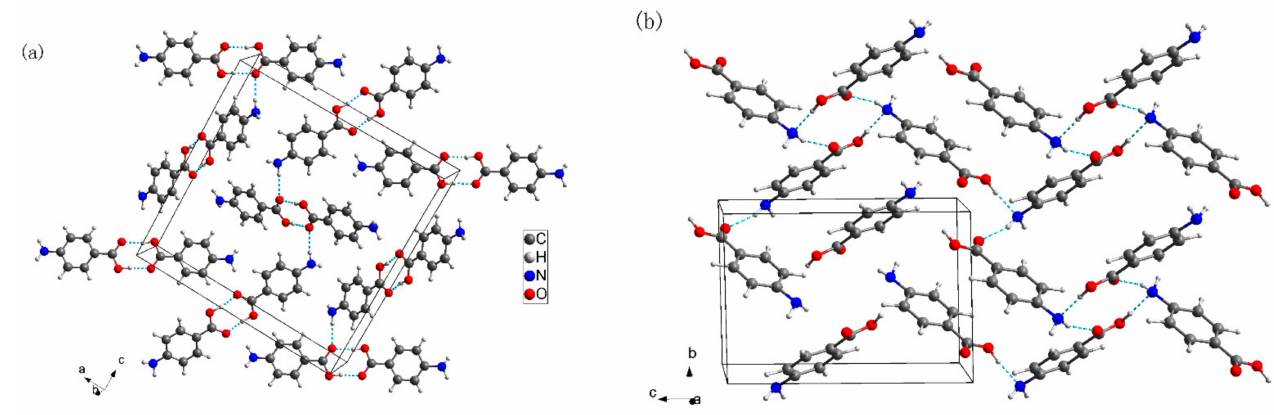
Figure 7. Crystal structures of ( a ) α -PABA and ( b ) β -PABA under ambient conditions: the hydrogen bonds are marked as dashed lines. Reprinted with permission from Ref. [87]. Copyright 2014 Royal Society of